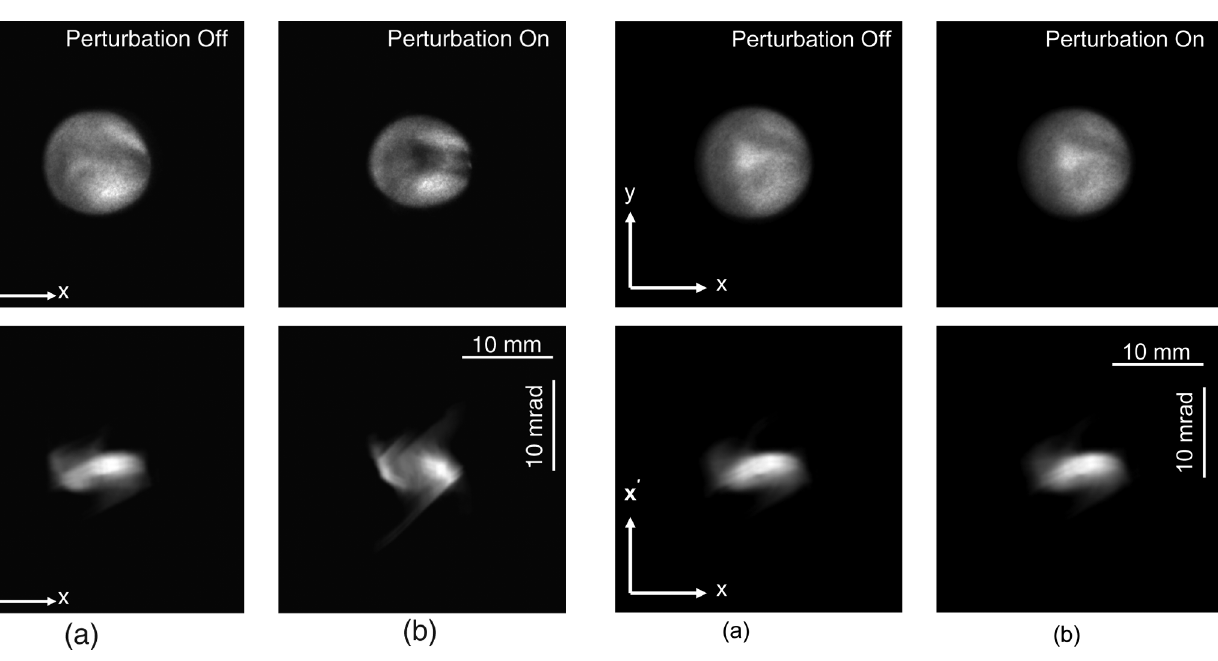
beam.FIG. 4. Beam configuration space (top) and measured x - x 0 phase space by tomography (bottom) reconstructed at LC1: (a) Without, and (b) with the perturbation. The subtracted slope (cid:6) is shown in Table